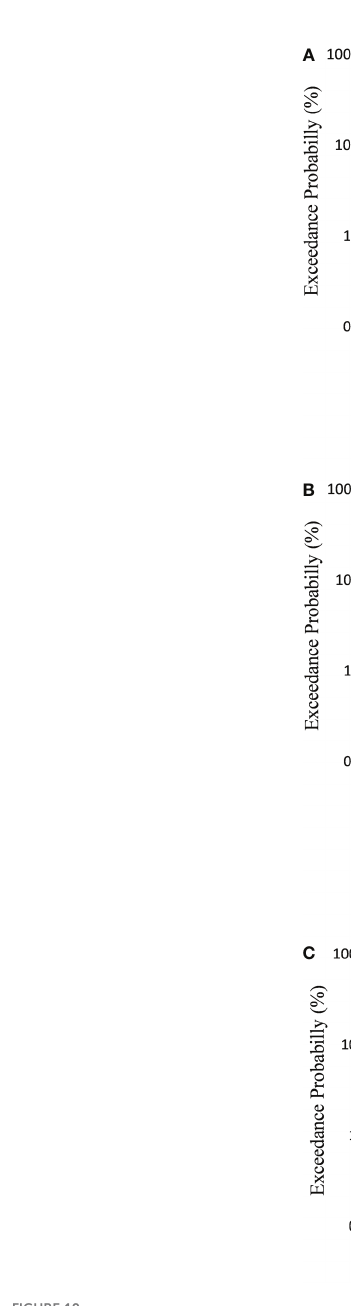
FIGURE 10 Example of the best fi ts of the Weibull distribution to the peak value of normal stress. (A) Example of a mediocre fi t from trial 21 (pressure gauge P2). (B) Example of a good fi t from trial 11 (pressure gauge P7). (C) Example of a poor fi t from trial 21 (pressure gauge